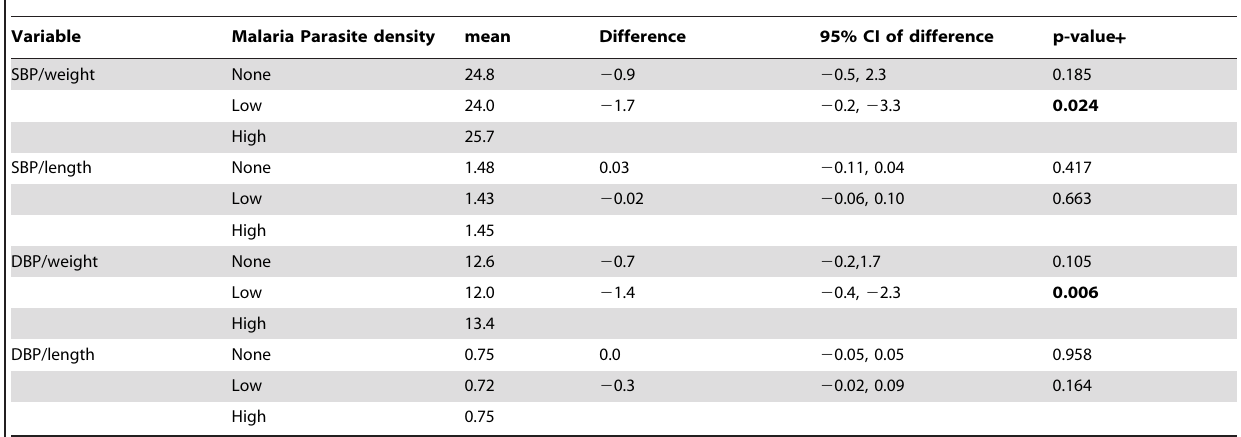
Table 6. Association between maternal malaria parasite load and newborn SBP and DBP adjusted for birth weight and length.